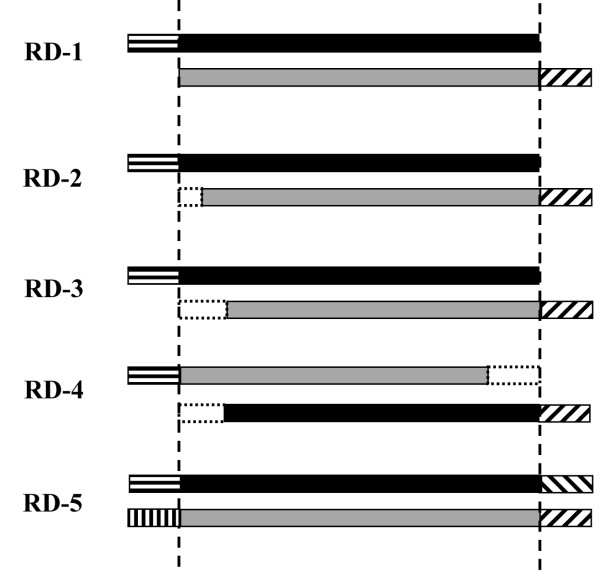
Templates-pairs used for the recombination of mRFP (black) and DsRed (grey). Parental sequences or parental background are either mRFP WT or DsRed WT genes. Digested GFP pProTeT plasmids were used as cloning vectors for inserts to ensure that only fully cut plasmids were ligated with chimeric inserts.